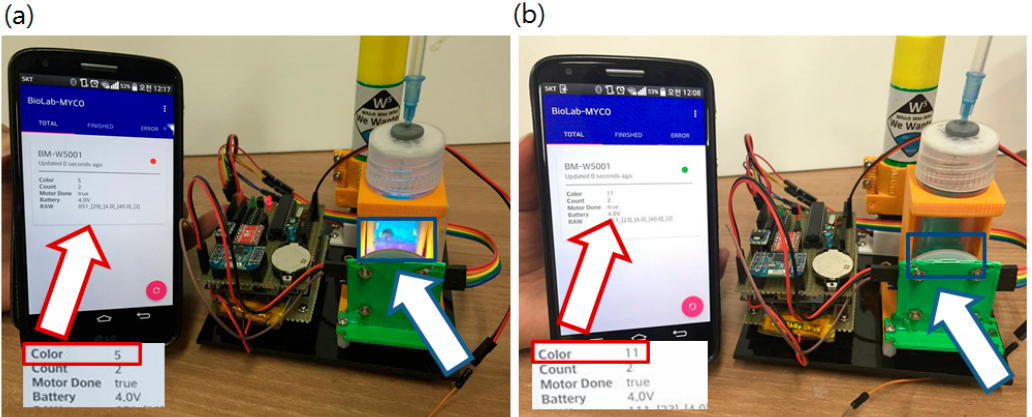
Figure 10. Operating sensor node with the android application. White boxes under the red arrows are closer view of the screen. Red boxed number after the Color label shows kHz level frequency value output from the color sensor. (5 indicates 5 kHz output) ( a ) Status reported from the App. (red arrow) when a positive sample (purple liquid in the blue box indicated by blue arrow) was introduced. Dropped color value from 11 kHz to 5 kHz means red pigment generated; ( b ) Report changed when a blank sample (clear-blue liquid in the blue box pointed by blue arrow) was introduced. Color value did not changed and remains still at 11 kHz. Red/Green circled indication mark (red for positive) changes and sensor values are updated.